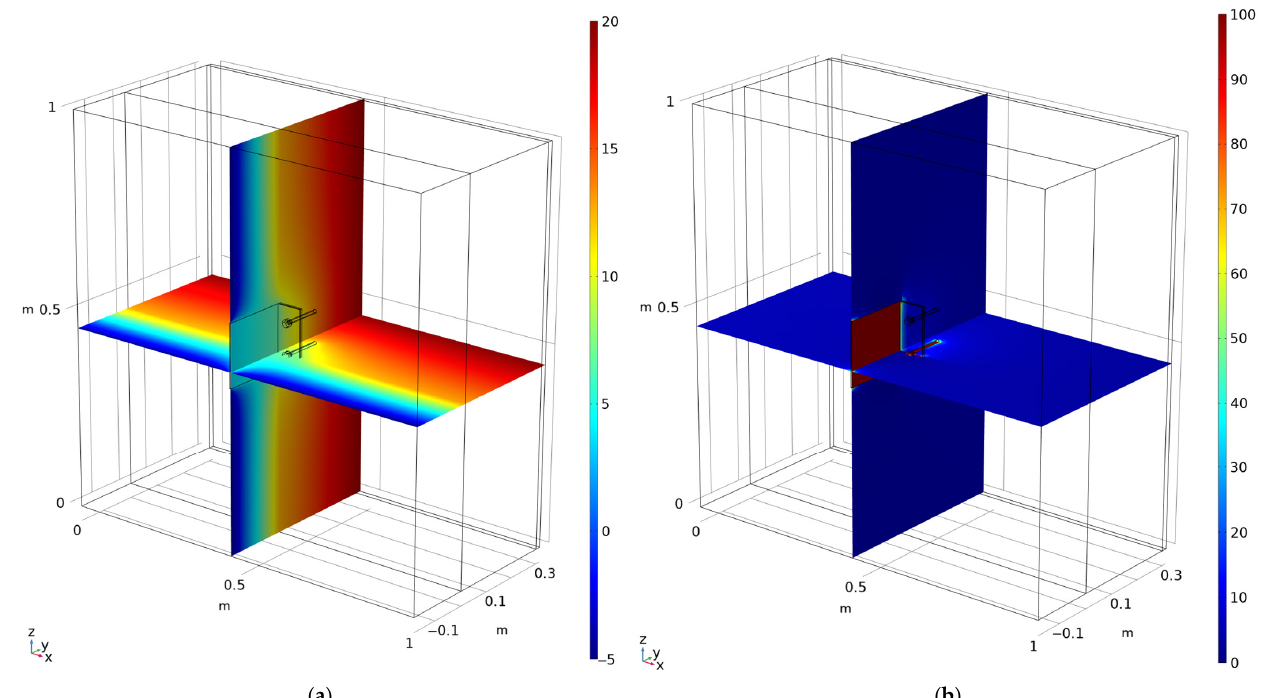
Figure 3. 3D models showing the results using vertical and horizontal sections for ( a ) temperature distribution (°C) and ( b ) heat flux density (W/m 2 ).